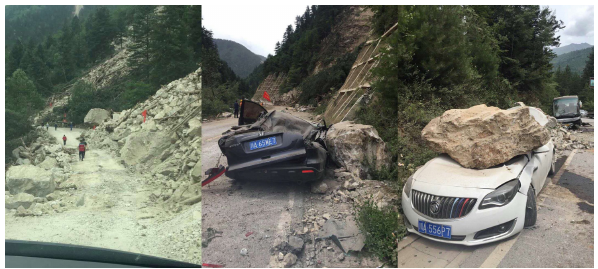
Figure 2. Landslides and rockfalls in the disaster